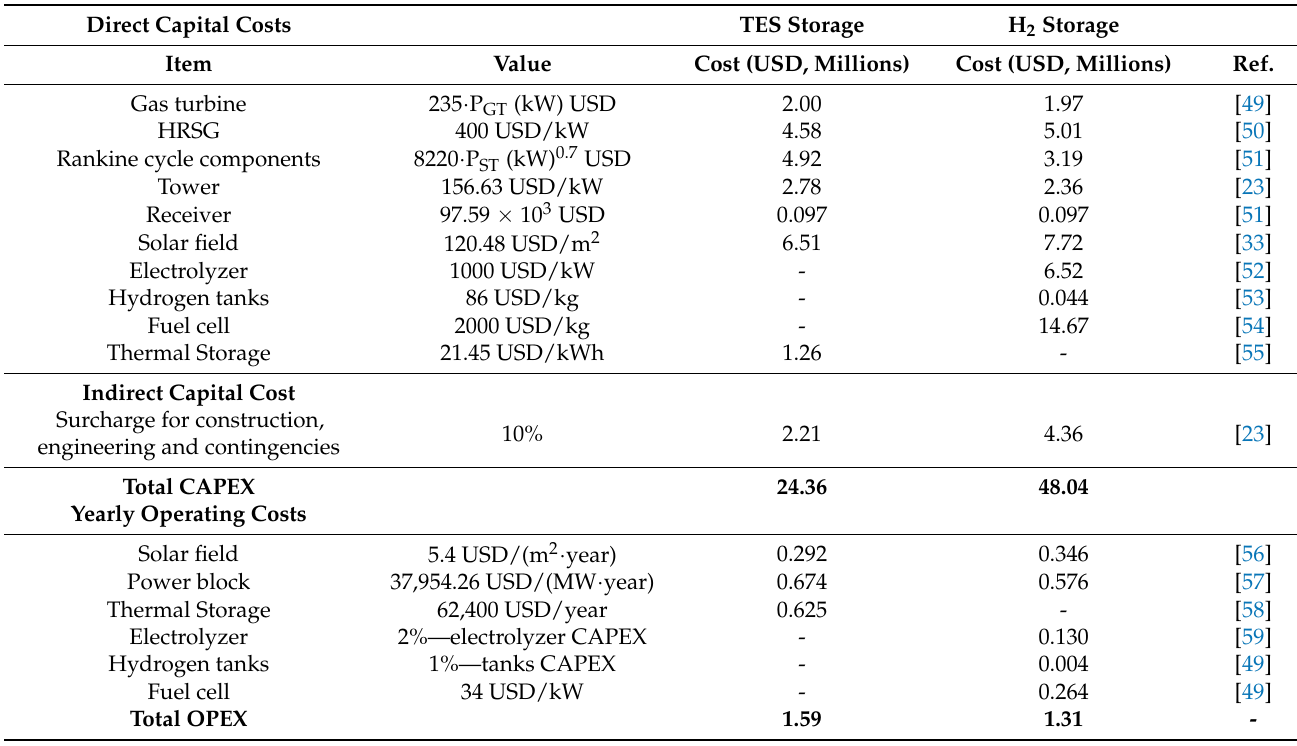
Table 6. CAPEX and OPEX estimation for TES storage (Approach A) and hydrogen systems (Approach B). Direct Capital